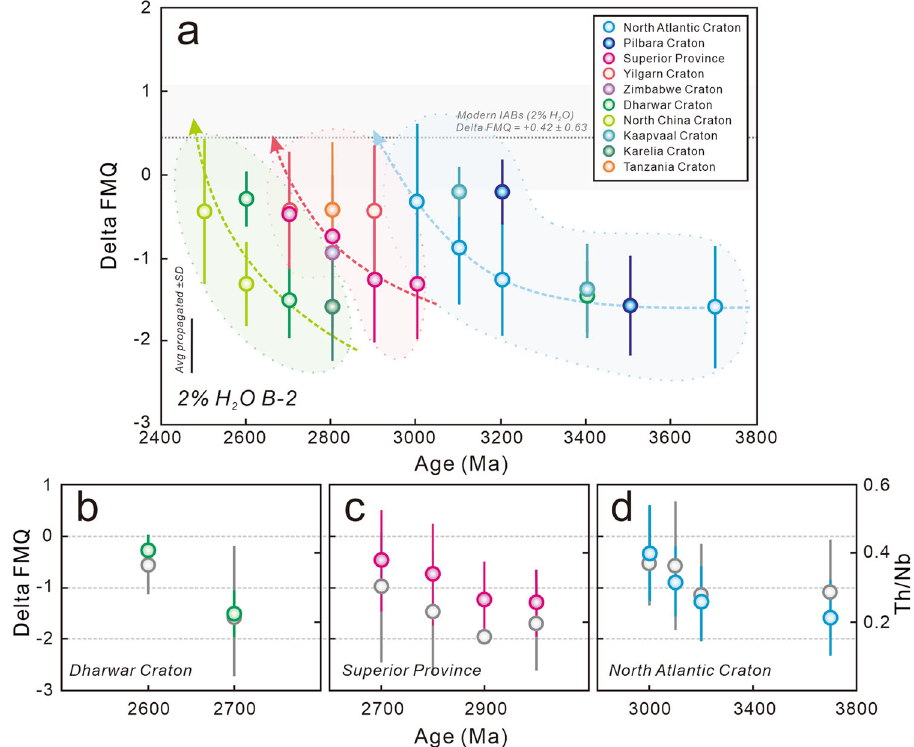
Fig. 2 Redox state of Archean Basalt-2 (B-2) samples at 2 wt.% H 2 O. a , The f O 2 estimations of B-2 samples. The f O 2 value and uncertainty (grey interval) of modern island arc basalts (IABs) at 2 wt.% H 2 O were used for comparison 14 . The uncertainties in the bottom left corner represent the average 1 standard deviation (SD) propagation of B-2 samples. b - d The time evolution of f O 2 estimations and Th/Nb ratios in the Dharwar Craton, Superior Province and North Atlantic Craton, respectively. The grey symbols are the B-2 Th/Nb ratios. Error bars show the 1 SD of the means.